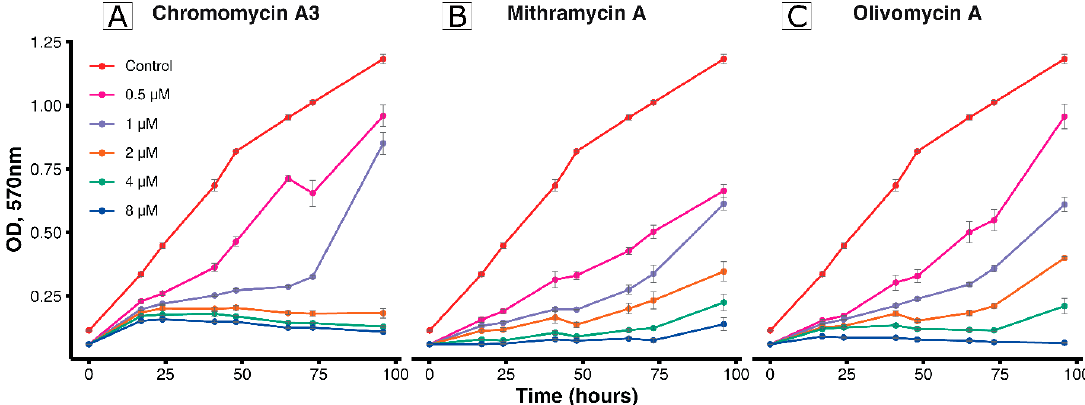
Figure 2. Evaluation of the drug’s inhibitory effect.